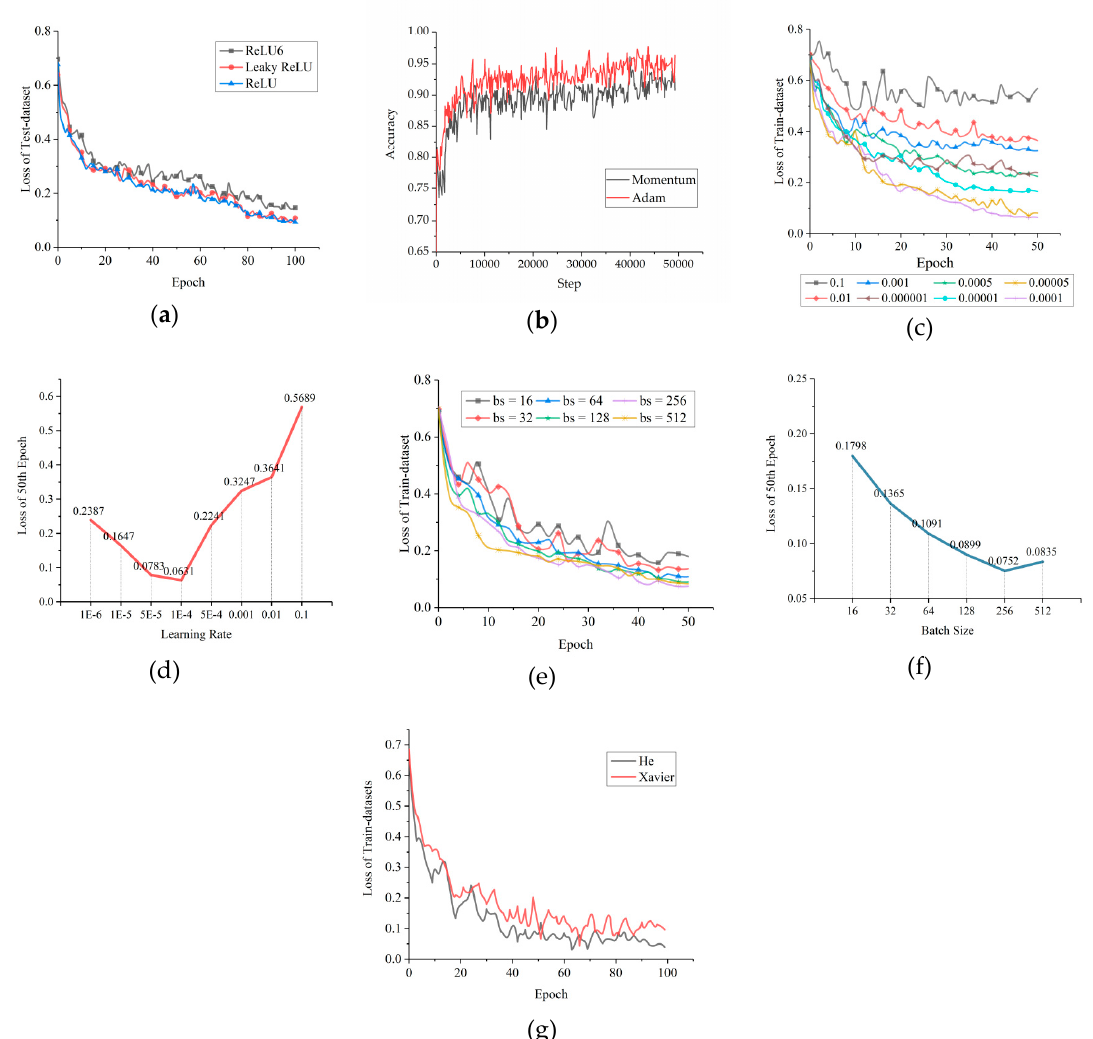
Figure 7. Some curves of adjustment results in hyperparameter evaluation: ( a ) Different kinds of activation functions influence the decrease of loss value; ( b ) the two optimization algorithms achieve distinct accuracy trends; ( c ) the influence of the initial learning rate on the downtrend of loss; ( d ) loss values of the 50th Epoch in ( c ); ( e ) the influence of the batch size on the downtrend of loss; ( f ) loss values of the 50th Epoch in ( e ); ( g ) the influence of different initialization methods on training.